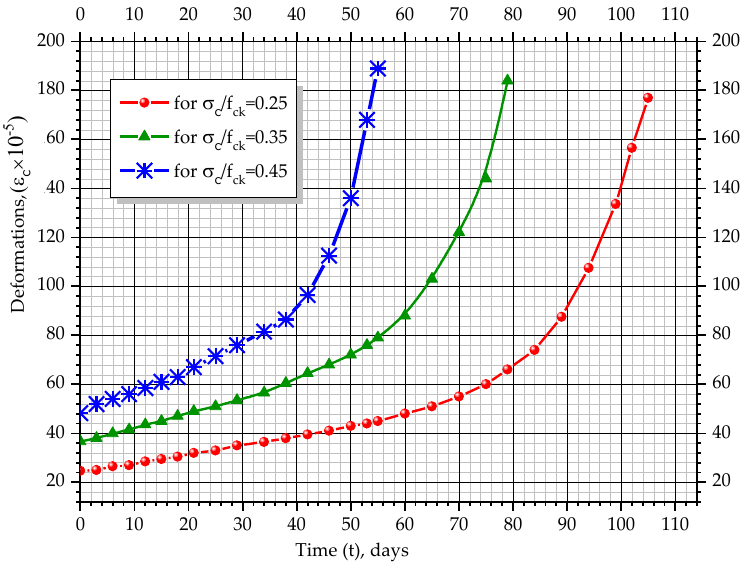
Figure 9. Changes in concrete deformation for tested prisms.